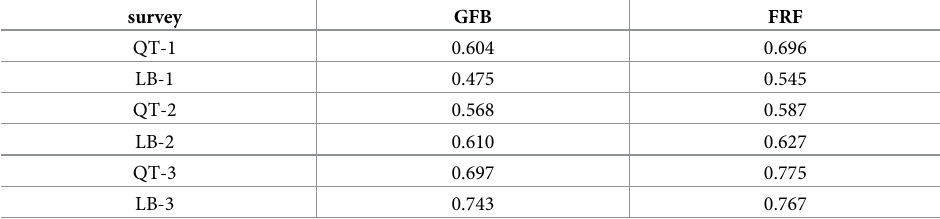
Table 3. Spearman correlation between the log-odds ratio obtained from the aggregate observer (AO) and the machine classifiers over the N = 200 images in each survey. All values are significant with p < 0.001.